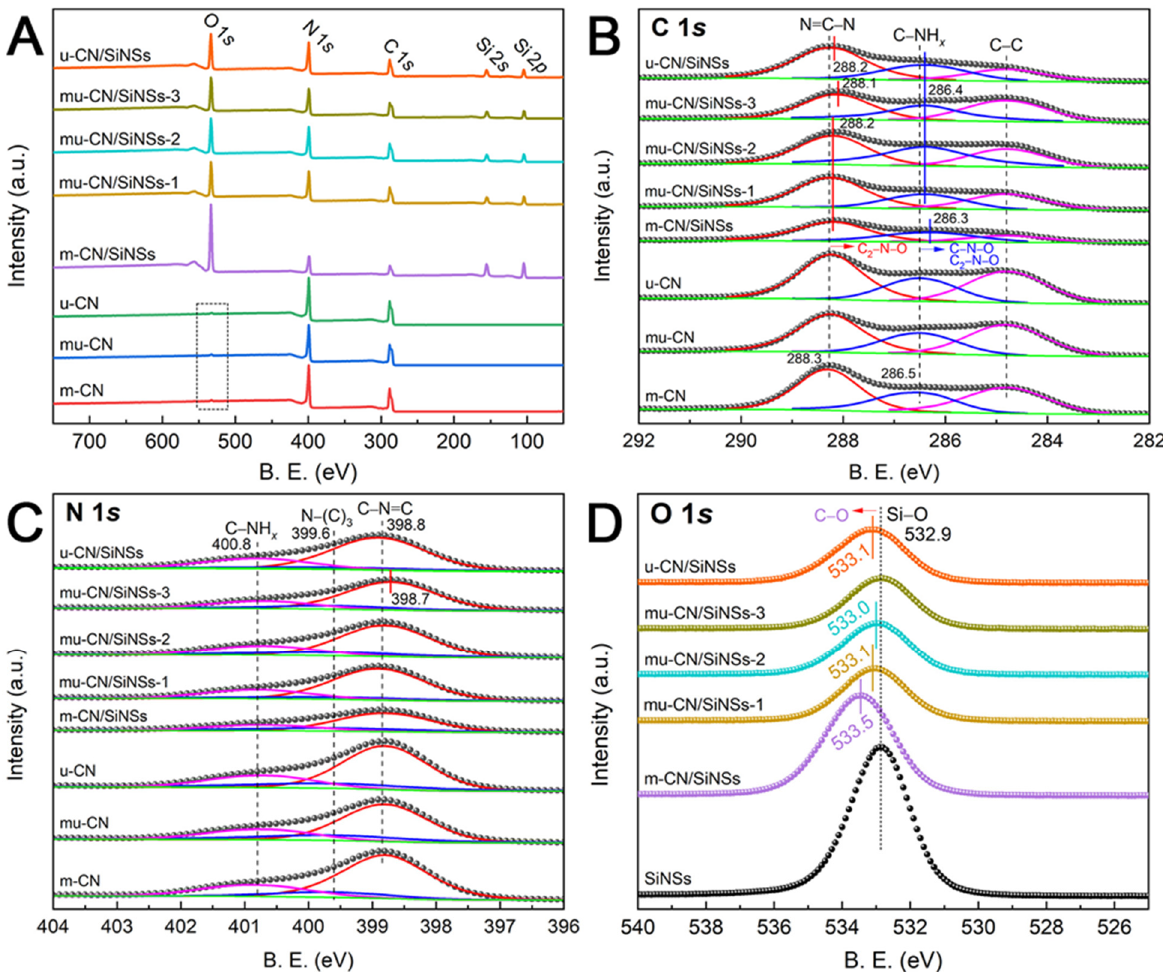
Figure 4. ( A ) XPS survey spectra and high-resolution ( B ) C 1 s , ( C ) N 1 s , and ( D ) O 1 s spectra after Ar +